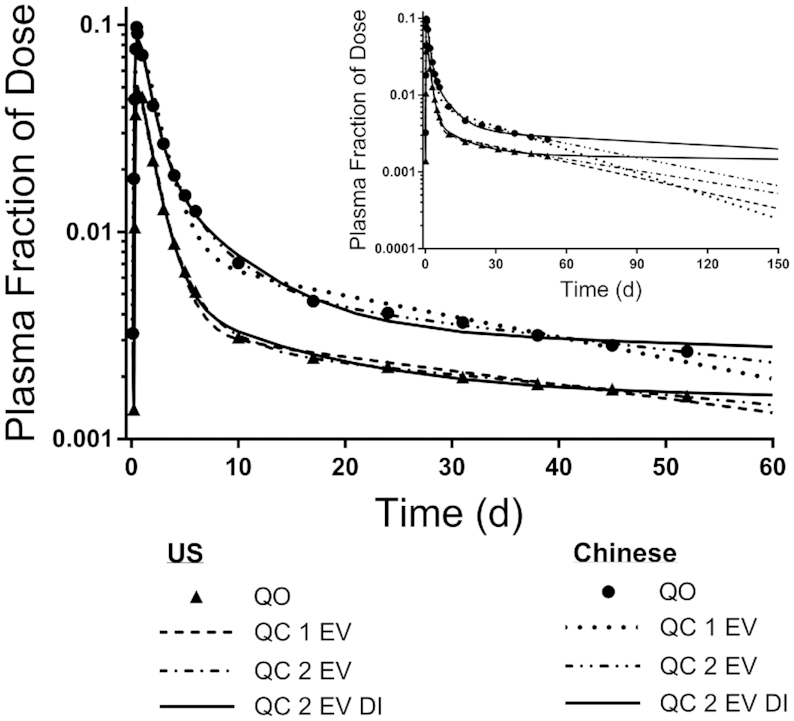
Model-predicted fraction of dose for [2H8]retinol in plasma versus time. Observed data (QO; symbols) are geometric mean fraction of dose for a group of older US (n = 7) and Chinese adults (n = 6) and model-calculated (QC) fits (lines) using a model (Figure 1) with 1 ‘extravascular’ compartment (1 EV) or 2 extravascular compartments (without or with ‘dietary intake’ data as an input; 2 EV and 2 EV DI, respectively). The inset shows model-simulated data to 150 d using the 3 models.